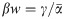
Geographic patterns of β–diversity for terrestrial vertebrates at different spatial scales in Mexico.The maps represent the spatial pattern of β–diversity by taxa and at different spatial scales. β–diversity was calculated with the multiplicative formula proposed by Whittaker βw=γ/α¯ [1], where γ is gamma diversity (the number of species in a region) and αmean is alpha diversity (the average number of species of the sites that conform the region). A region is one of the cells in which the country was subdivided, and the sites included all the pixels of 1 km2 from each region.